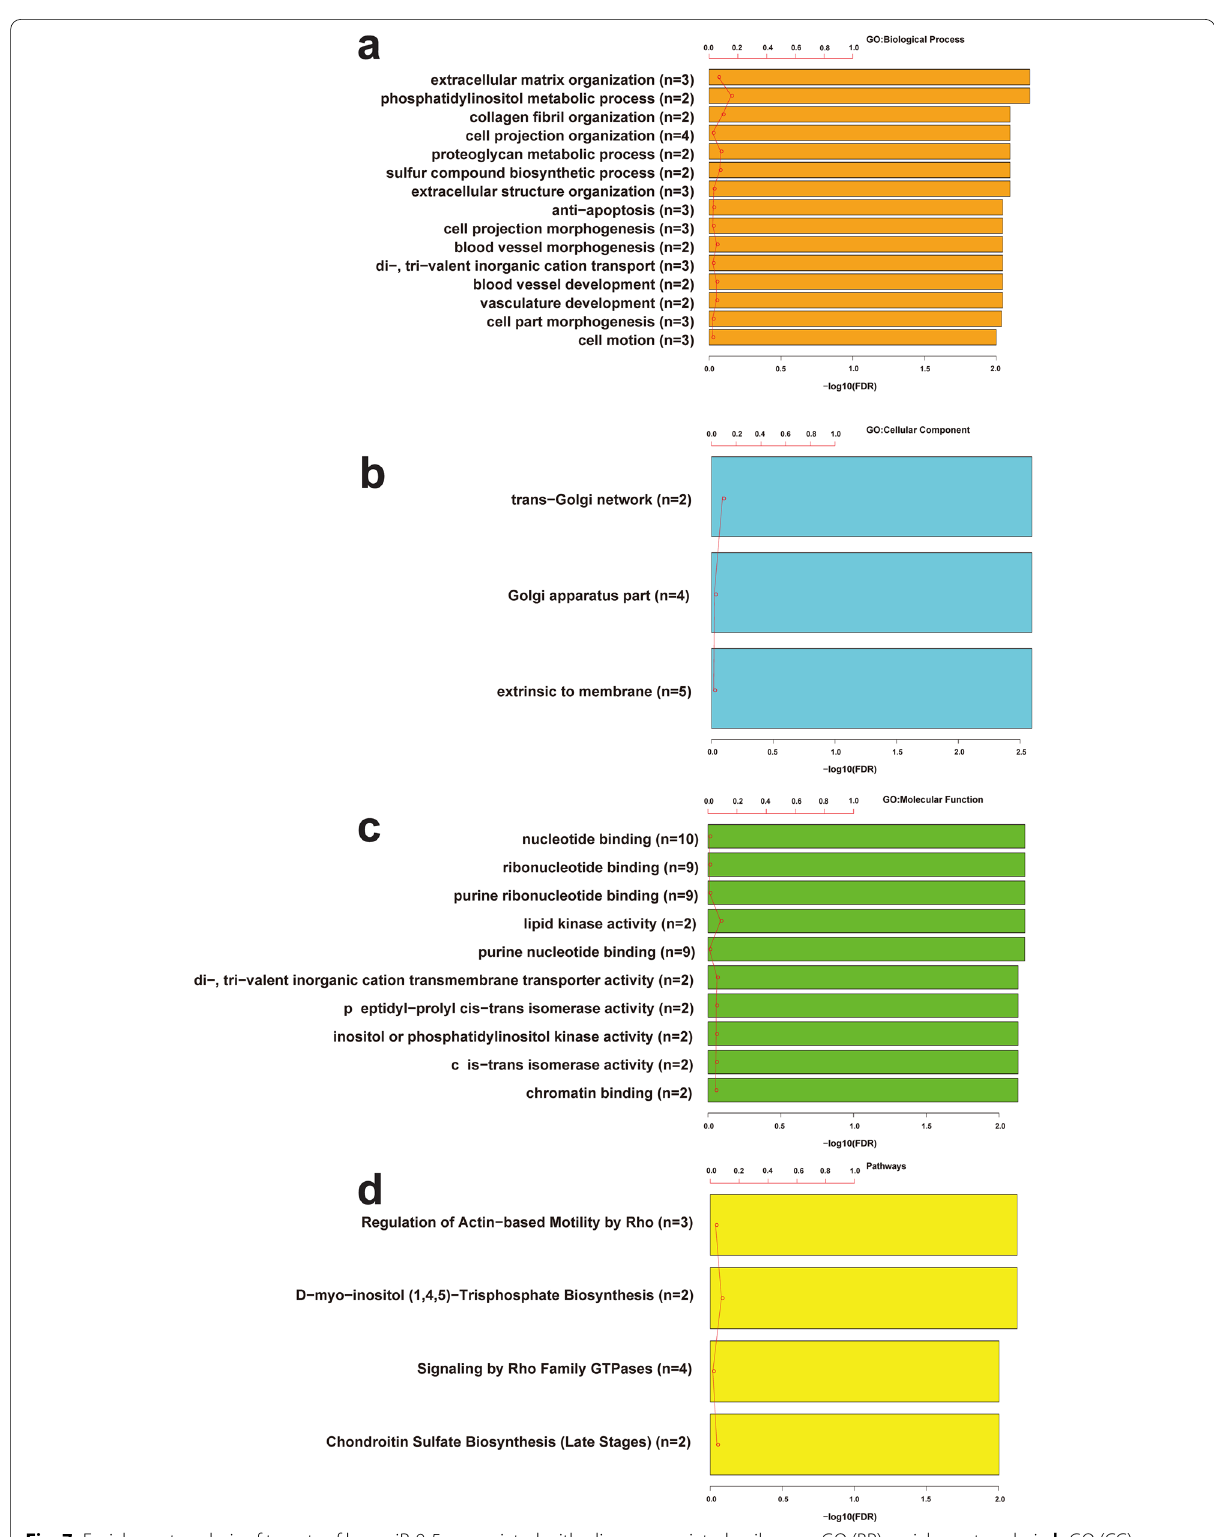
Fig. 7 Enrichment analysis of targets of hsa-miR-9-5p associated with glioma-associated epilepsy. a GO (BP) enrichment analysis. b GO (CC) enrichment analysis. c GO (MF) enrichment analysis. d KEGG enrichment